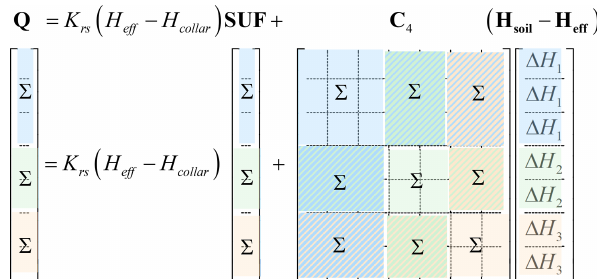
Figure 2. Upscaling of the SUF and C 4 matrix by simply taking the sum of elements that correspond with nodes where the soil water hydraulic heads are the same. Nodes with the same water hydraulic heads are grouped in layers and are marked with the same color. The elements of the marked blocks of the Q and SUF vectors and in the C 4 matrix are summed